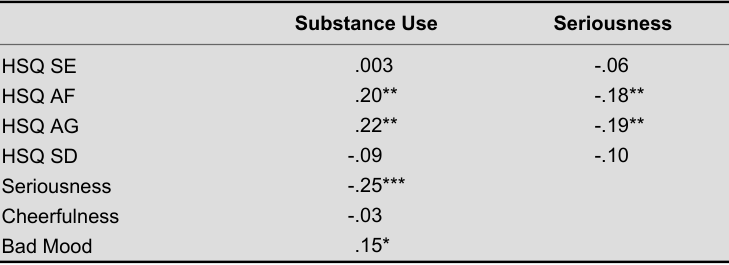
Correlations Between the Substance Use Composite and Scores on the HSQ and STCI-T as well as Correlations Between Seriousness and Scores on the HSQ